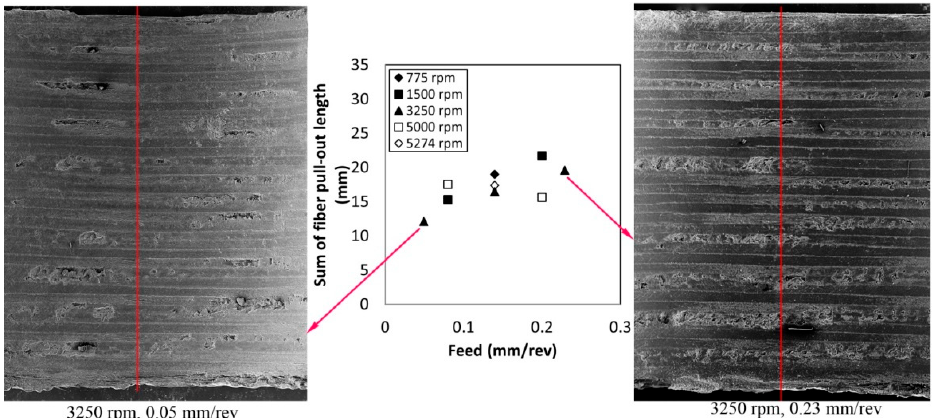
Figure 7. The effect of the drilling conditions on the sum of fiber pull-out lengths with two sample SEM images (the line on the SEM images indicates the center of the half hole surface).